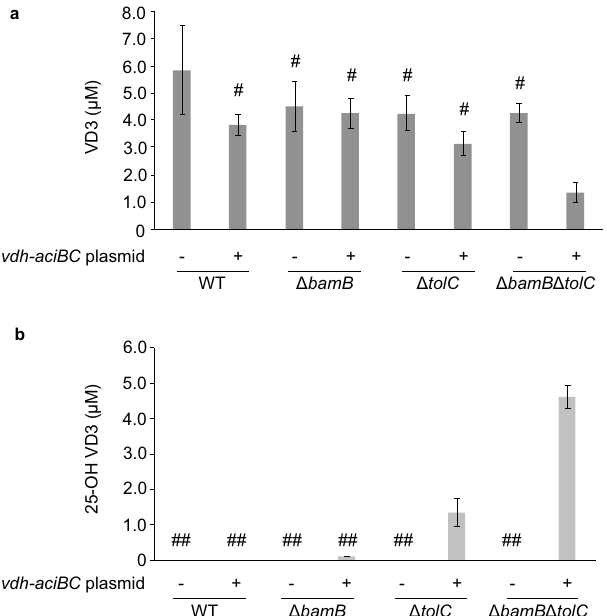
Figure 5. VD3 conversion efficiency of the mutants. Inactive VD3 was converted to active VD3 by using cells transformed with pHN1387 (empty vector control; vdh-aciBC plasmid−) or pHN4136 ( vdh-aciBC expression plasmid; vdh-aciBC plasmid+). The host cells used are indicated at the bottom of the graph. The quantification result of inactive VD3 that remained after the conversion reaction from triplicate experiments is presented as the mean ± standard error of the mean. Data were statistically analyzed using ANOVA, and significant differences were evaluated with Tukey’s multiple comparison test. One-way ANOVA showed a significant difference at F = 2.7 ( p = 0.046). The bars marked with “#” correspond with the groups that did not differ significantly from each other at adjusted p < 0.05 in the post hoc test. The unmarked bars correspond with the group that significantly differed from the other groups. ( b ) The quantification result of active VD3 produced after the conversion reaction is shown as in ( a ). VD3, vitamin D3; Δ bamB , outer membrane lipoprotein deletion mutant;